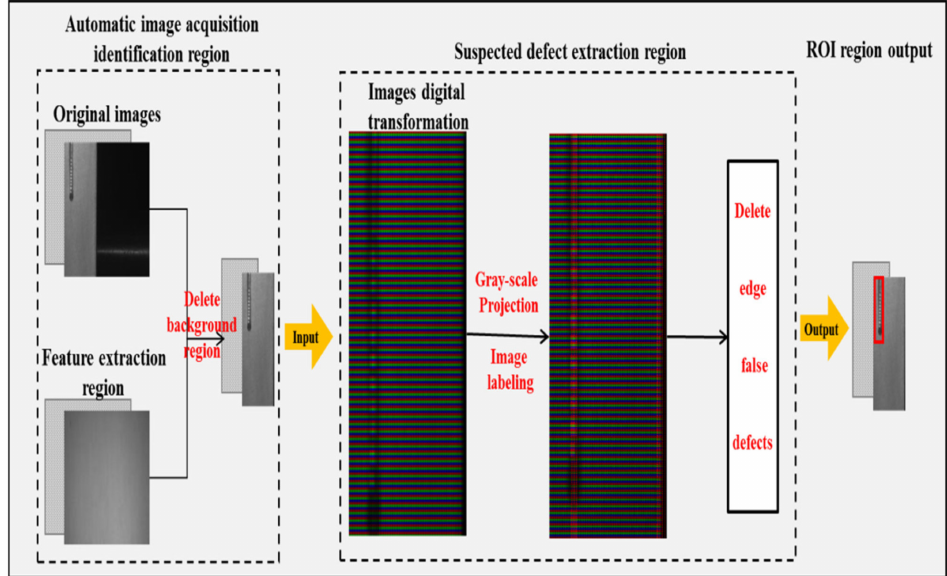
Figure 10. Process of strip steel surface rapidly quality screening and defect feature